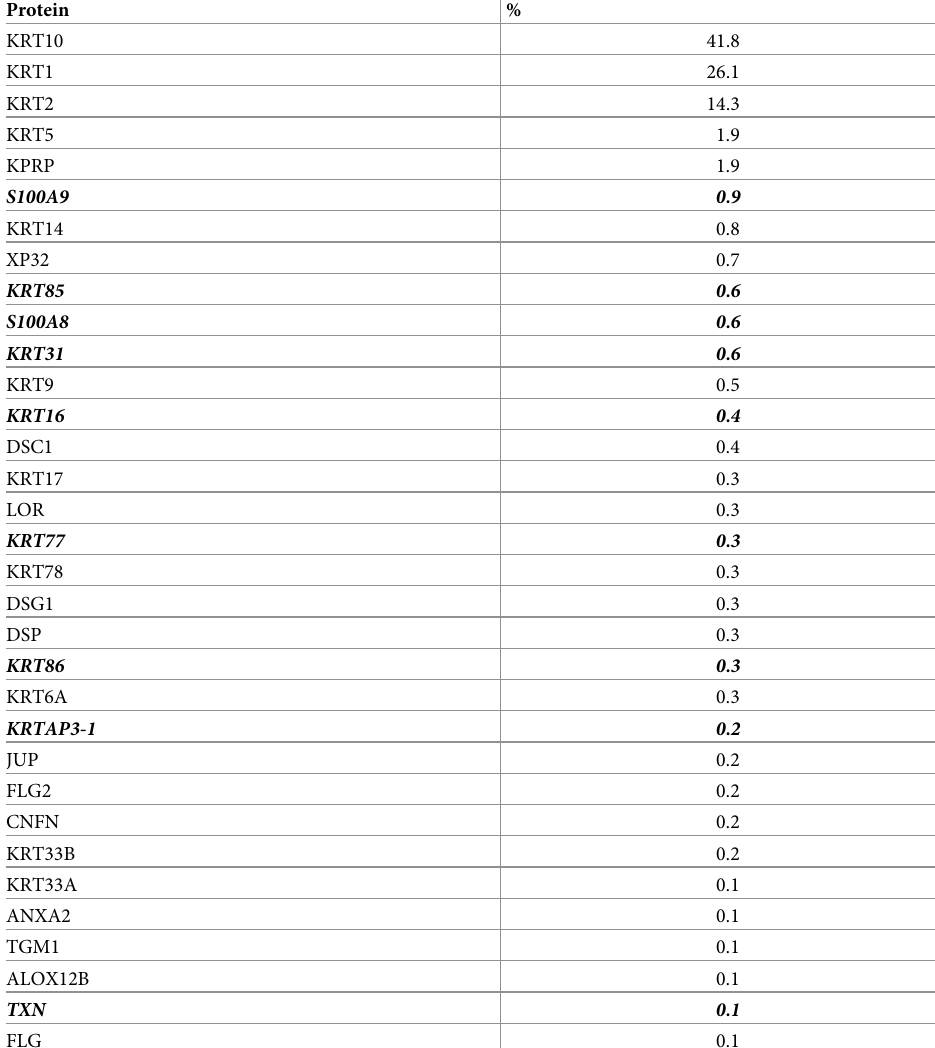
Table 2. Relative amounts of proteins identified in asymptomatic forehead stratum corneum by tape stripping. Protein % KRT10